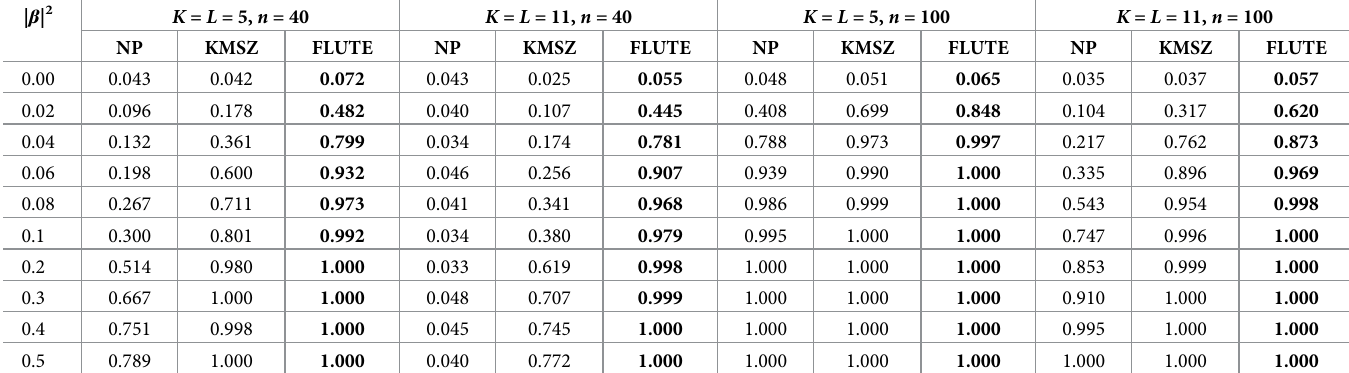
Table 2. Size and power for different tests at α = 0.05.